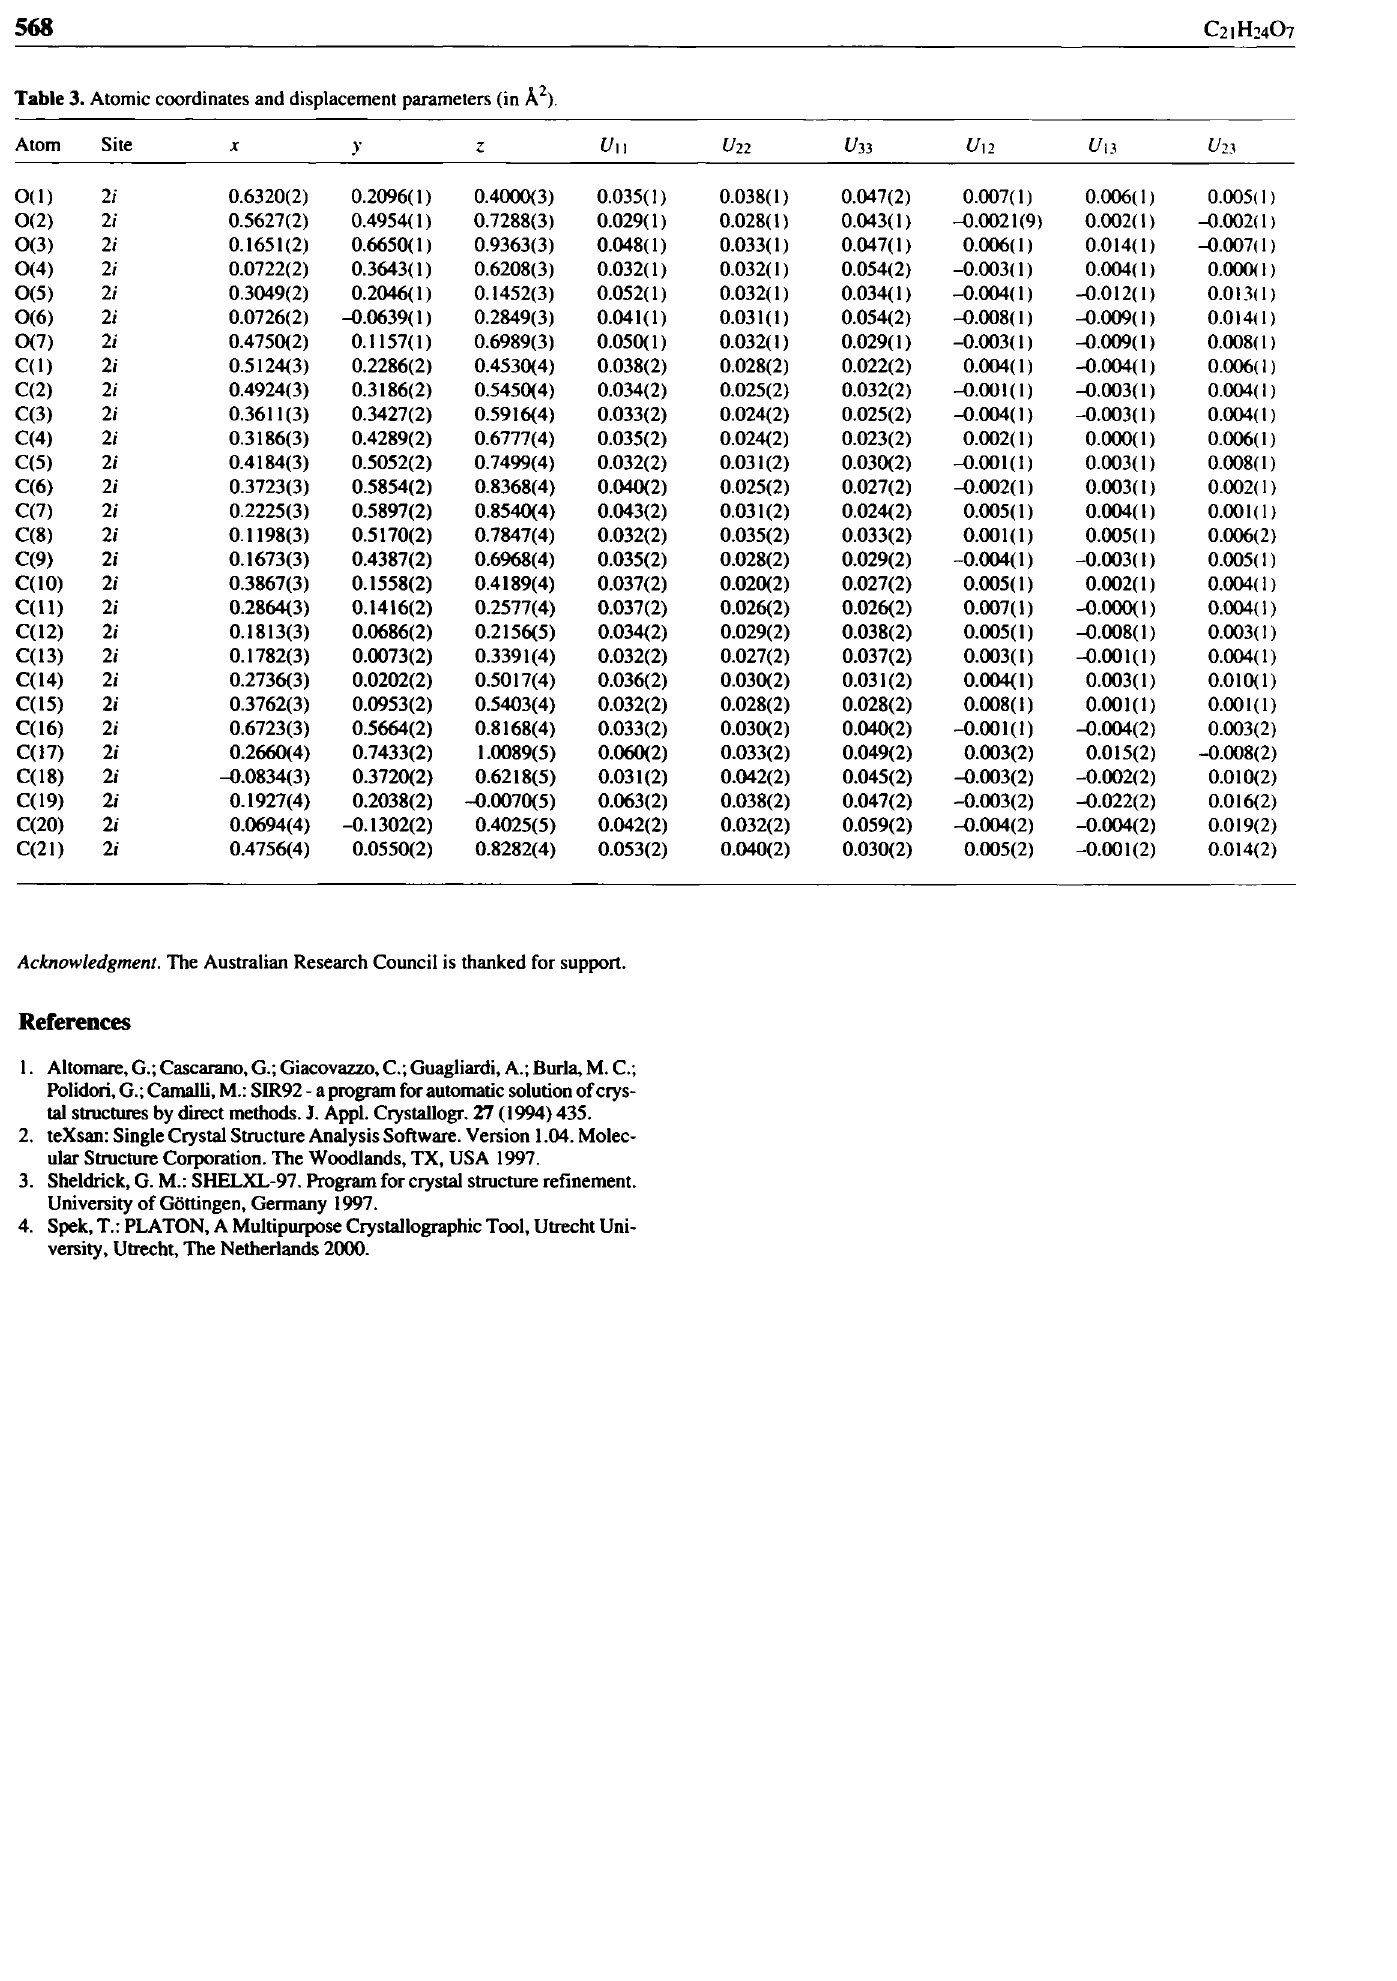
Table 3. Atomic coordinates and displacement parameters (in A 2